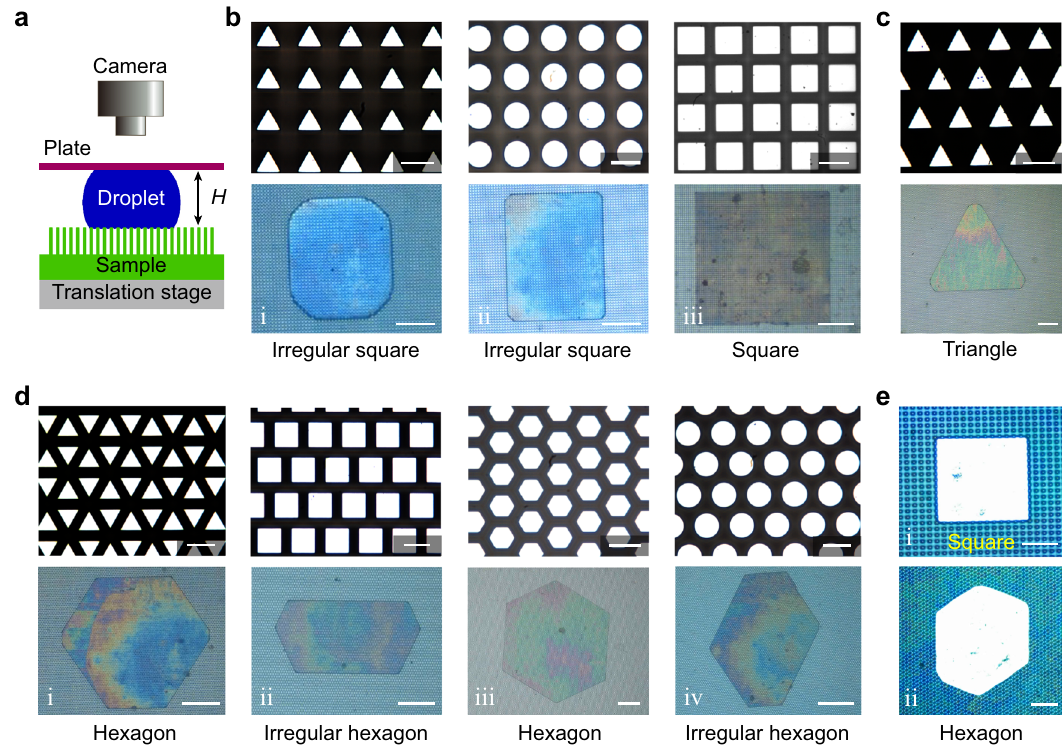
Fig. 1 Images of the experimental setup, various cross-sectional areas of micropillars, arrangements of arrays, and shapes of liquid fi lm patterns. a Schematic representation of the experimental setup used to perform con fi nement on the droplet (not drawn to scale). b Square and irregular square water droplet patterns created by the square arrangement of microtextures with triangular, circular, and square cross-sections (Supplementary Movie 1 – 3). c Triangular water droplet pattern created by a triangular arrangement of microtextures with a triangular cross-section (Supplementary Movie 4). d Hexagonal and irregular hexagonal water droplet patterns created by the hexagonal arrangement of microtextures with triangular, square, hexagonal, and circular cross-sections (Supplementary Movie 5 – 8). e Square and hexagonal liquid metal (Galinstan) droplet patterns, where ( e – i ) and ( e – ii ) have the same geometrical topologies (cross-section of micropillar and arrangement of array) as ( b – ii ) and ( d – i ), respectively. Scale bars for the arrays, 20 μ m. Scale bars for the droplet patterns, 500 μ m for ( b – d ) and 200 µ m for ( e